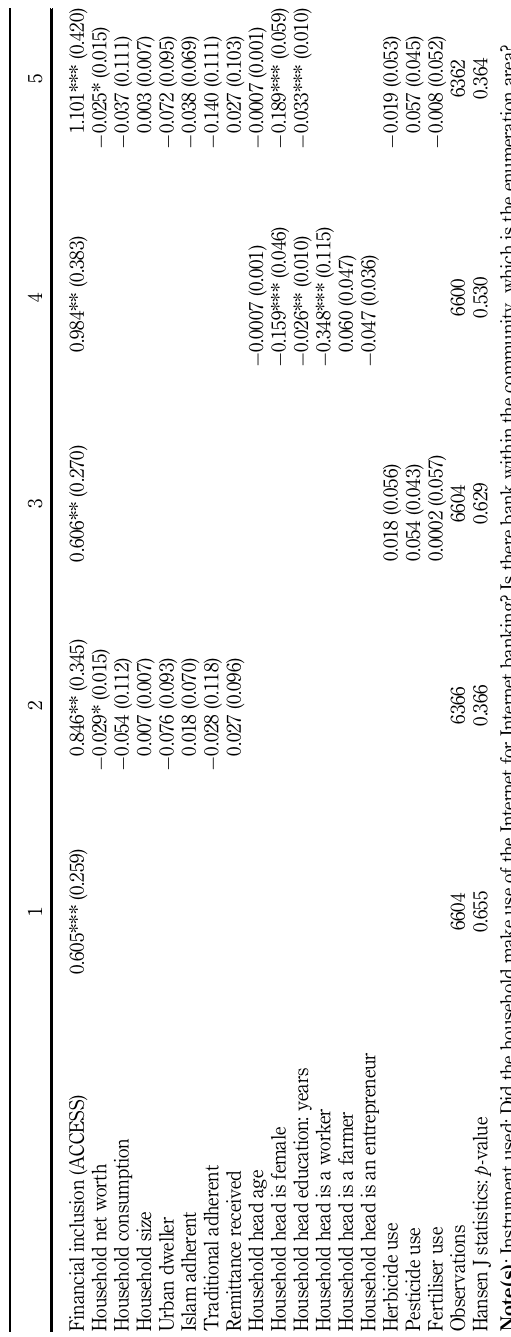
Table 2. Effects of financial inclusion (ACCESS) on agricultural productivity – instrumental variable